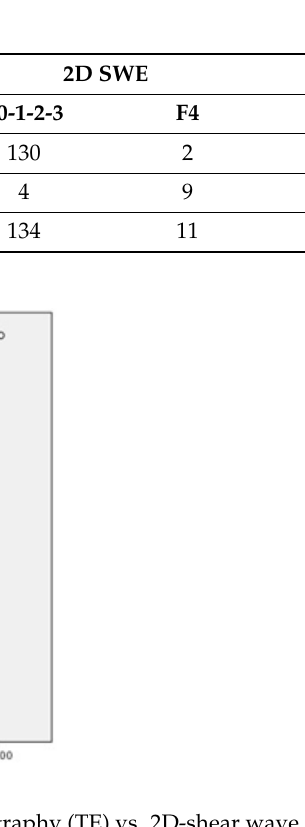
Table 3. Kappa coefficient index of agreement according to the different categories of liver fibrosis by both TE and SWE